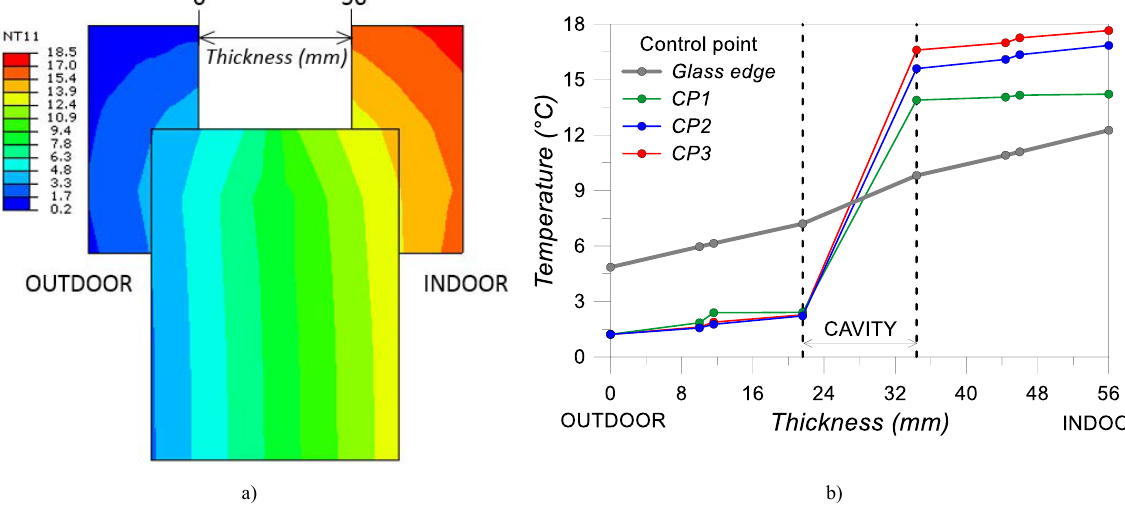
Fig. 10 FE thermal performance assessment of full-scale CLT-glass facade elements (P1 model). Temperature distribution: a) in the frame cross- section and b) in the thickness of glass, with a focus on the corner region (ABAQUS, values in